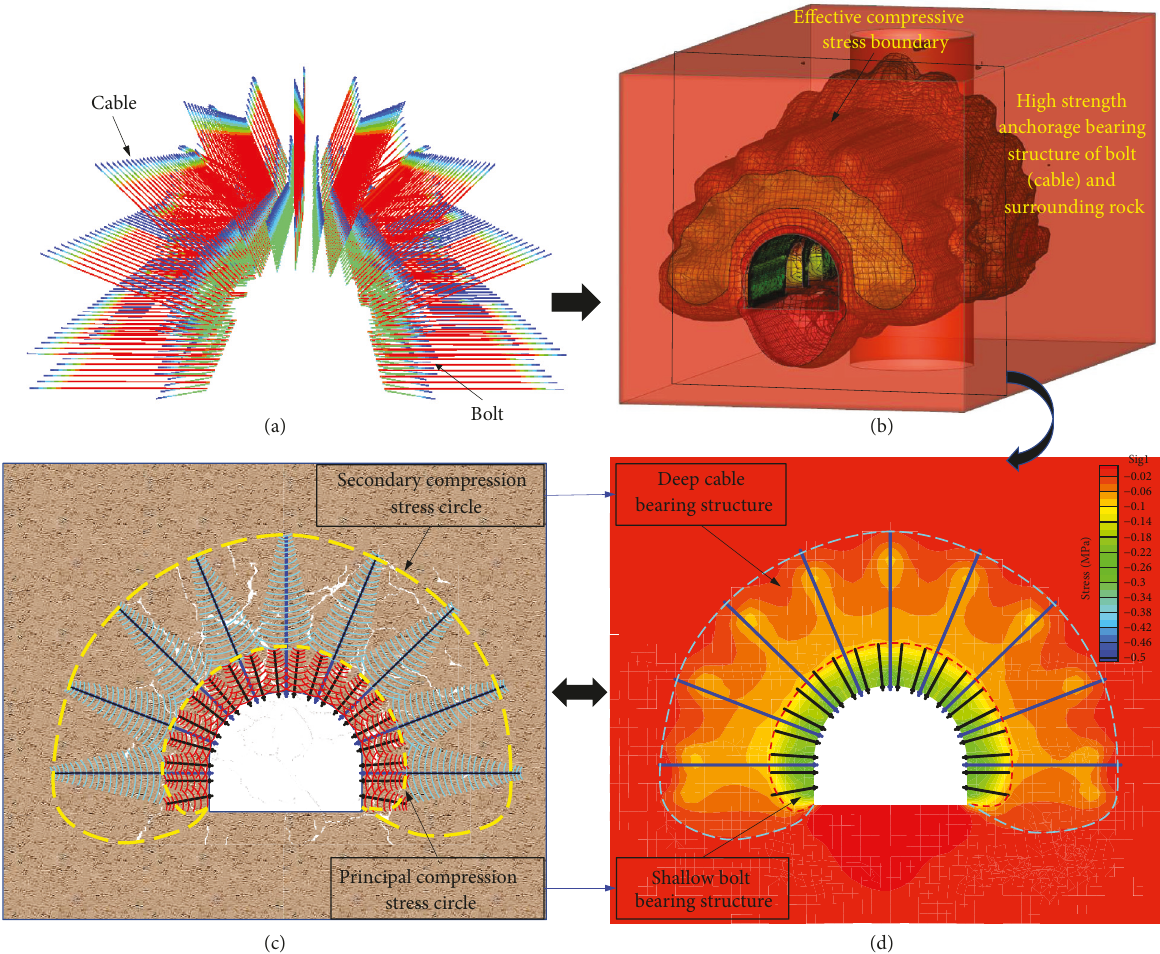
Figure 9: High strength anchorage bearing structure: (a) spatial arrangement of bolt (cable), (b) high strength anchorage bearing spatial structure, (c) principal and secondary compression stress circles, and (d) distribution of prestress field of bolt